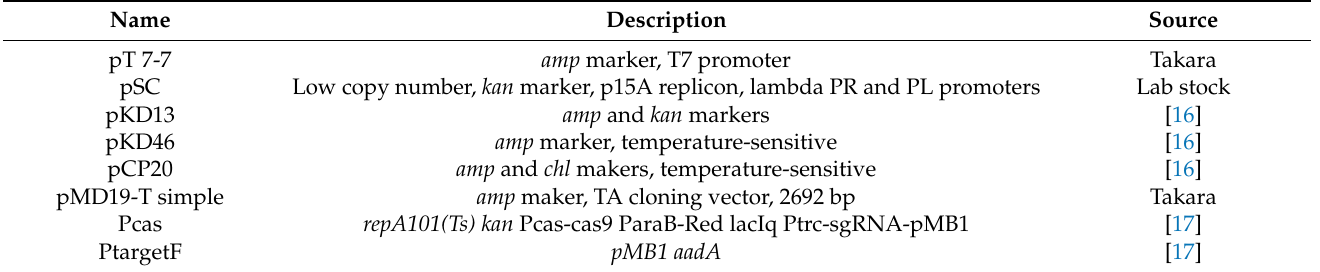
Table 2. The plasmids used in the